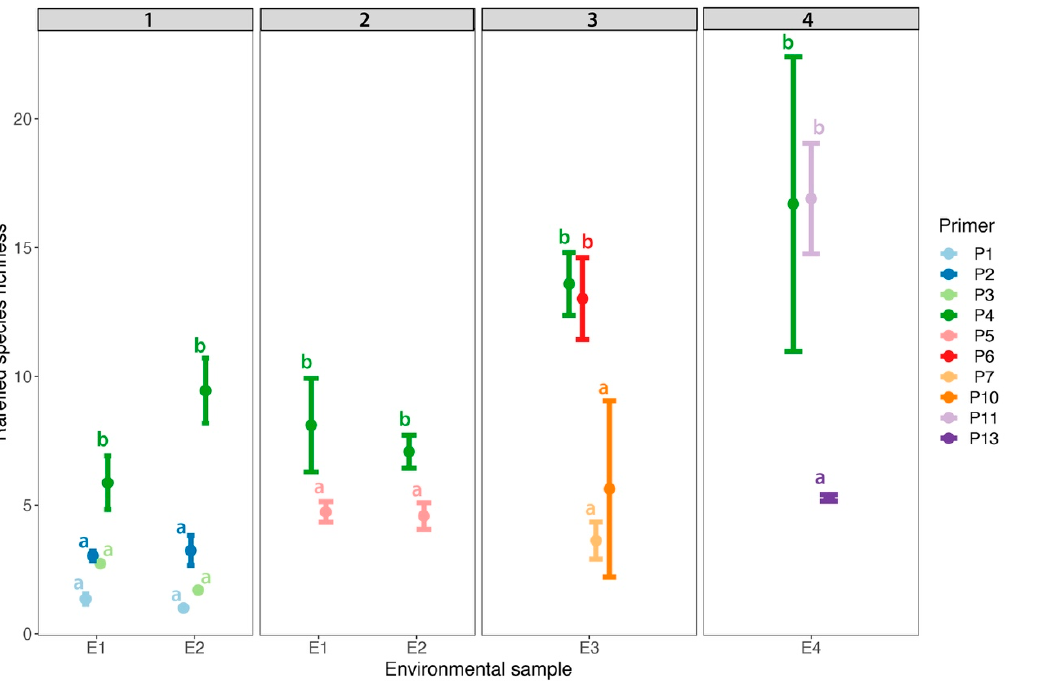
Figure 4. Mean rarefied species richness of environmental samples (i.e., E1–E4) across three replicates for 10 different primers. Each panel demonstrates the primers used across 4 sequencing runs. Letters indicate significant differences among primers in each run (i.e., each run was analysed separately). Points represent the means ± standard deviations.